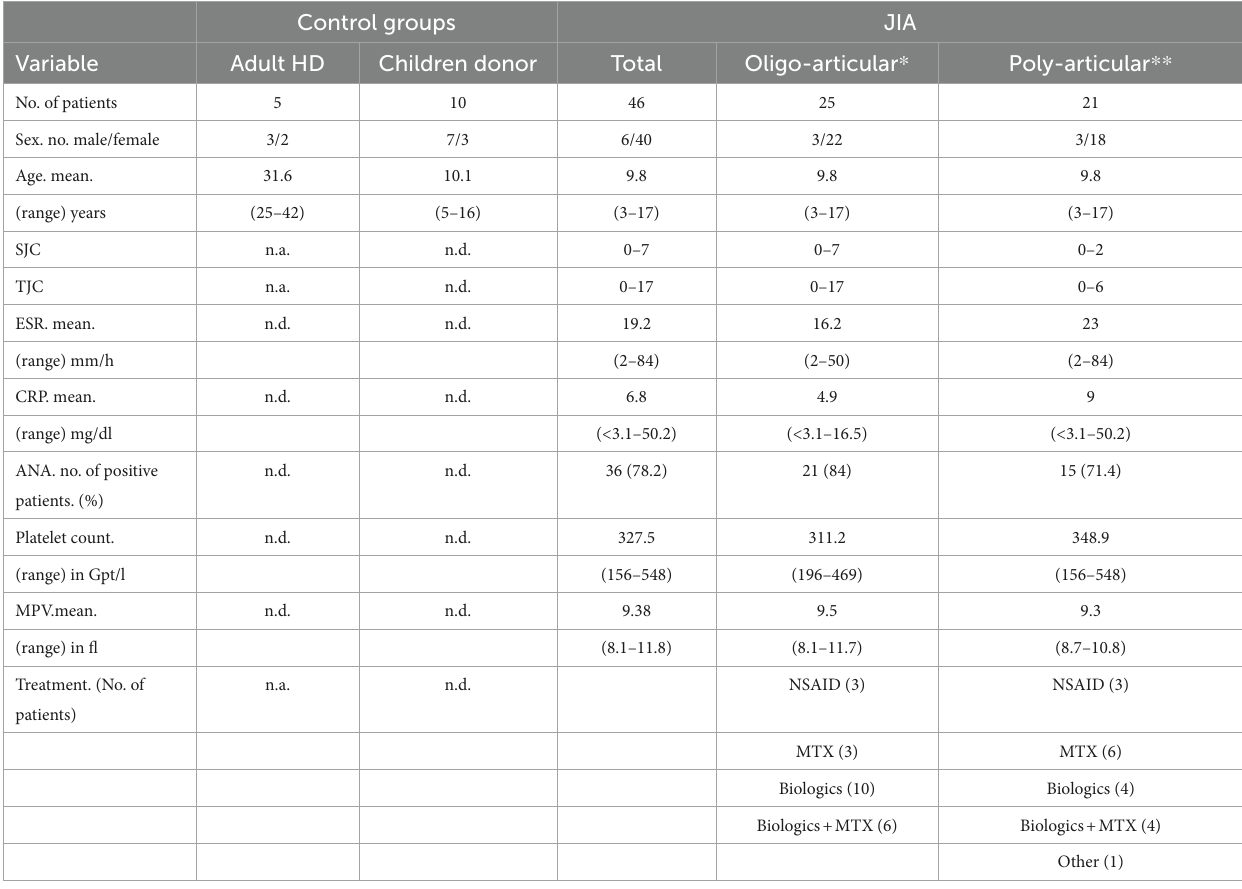
TABLE 1 Characteristic of control and patient